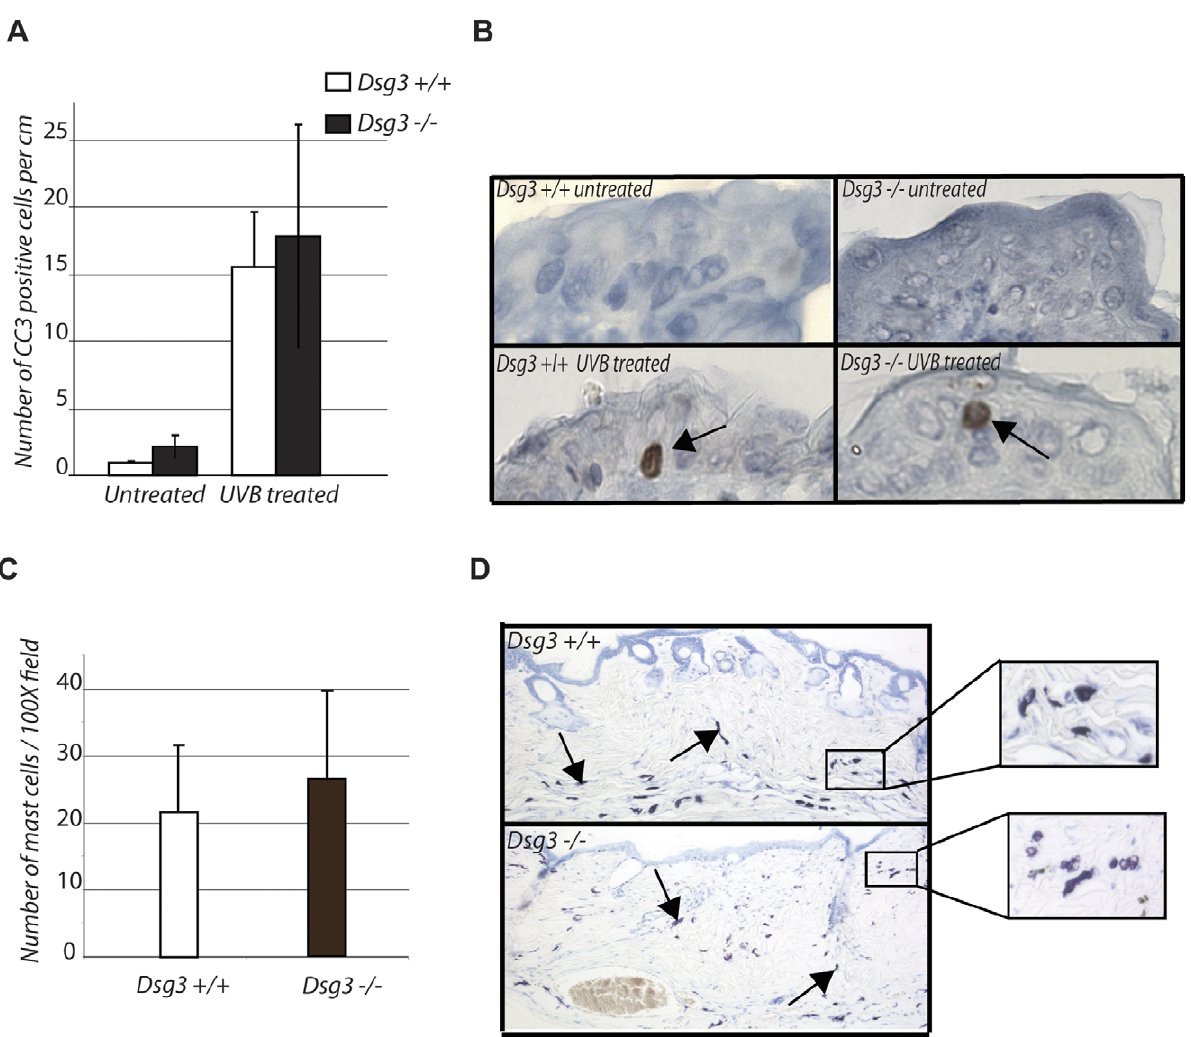
Figure 4. Dsg3 deficiency does not affect UVB-induced apoptosis or immune cell infiltration invivo. A) Graph indicating the average number of cleaved Caspase 3 (CC3) positive cells + / 2 SD per cm of epidermis in Dsg3 + / + and Dsg3 2 / 2 mice 24 hours after 2.5 kJ/m 2 UVB. n=3 for each condition. B) Representative images of cleaved Caspase 3 immunohistochemistry in the epidermis of mice analyzed in A). Arrows indicate the apoptotic cells. C) Graph indicating the average number of mast cells + / 2 SD in the skin of Dsg3 + / + and Dsg3 2 / 2 mice after 52 weeks of UVB treatment. n=12 for Dsg3 + / + mice and n=5 for Dsg3 2 / 2 mice. D) Representative toluidine blue staining of the skin of Dsg3 + / + and Dsg3 2 / 2 mice after 52 weeks of UVB treatment. Arrows indicate mast cells stained by toluidine blue. Insets show higher magnification images of toluidine blue- stained skins, highlighting mast cells.